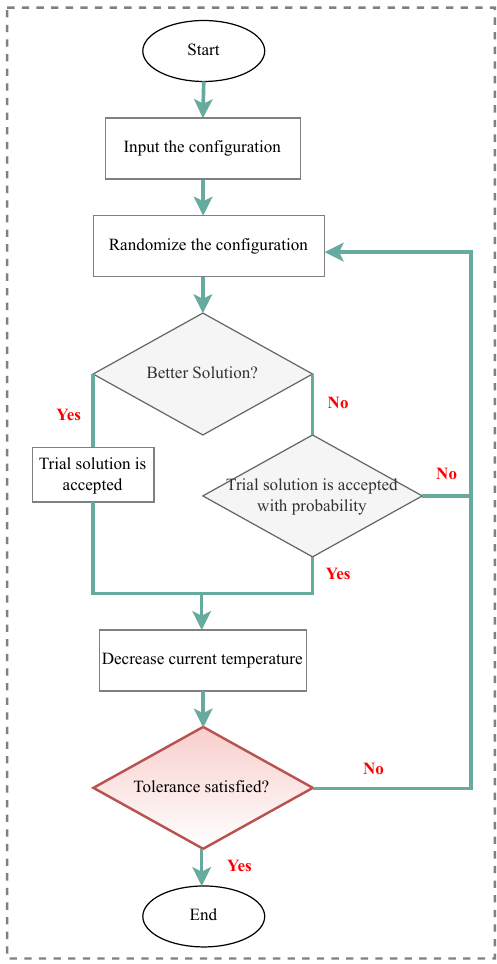
Figure 15. Flowchart of